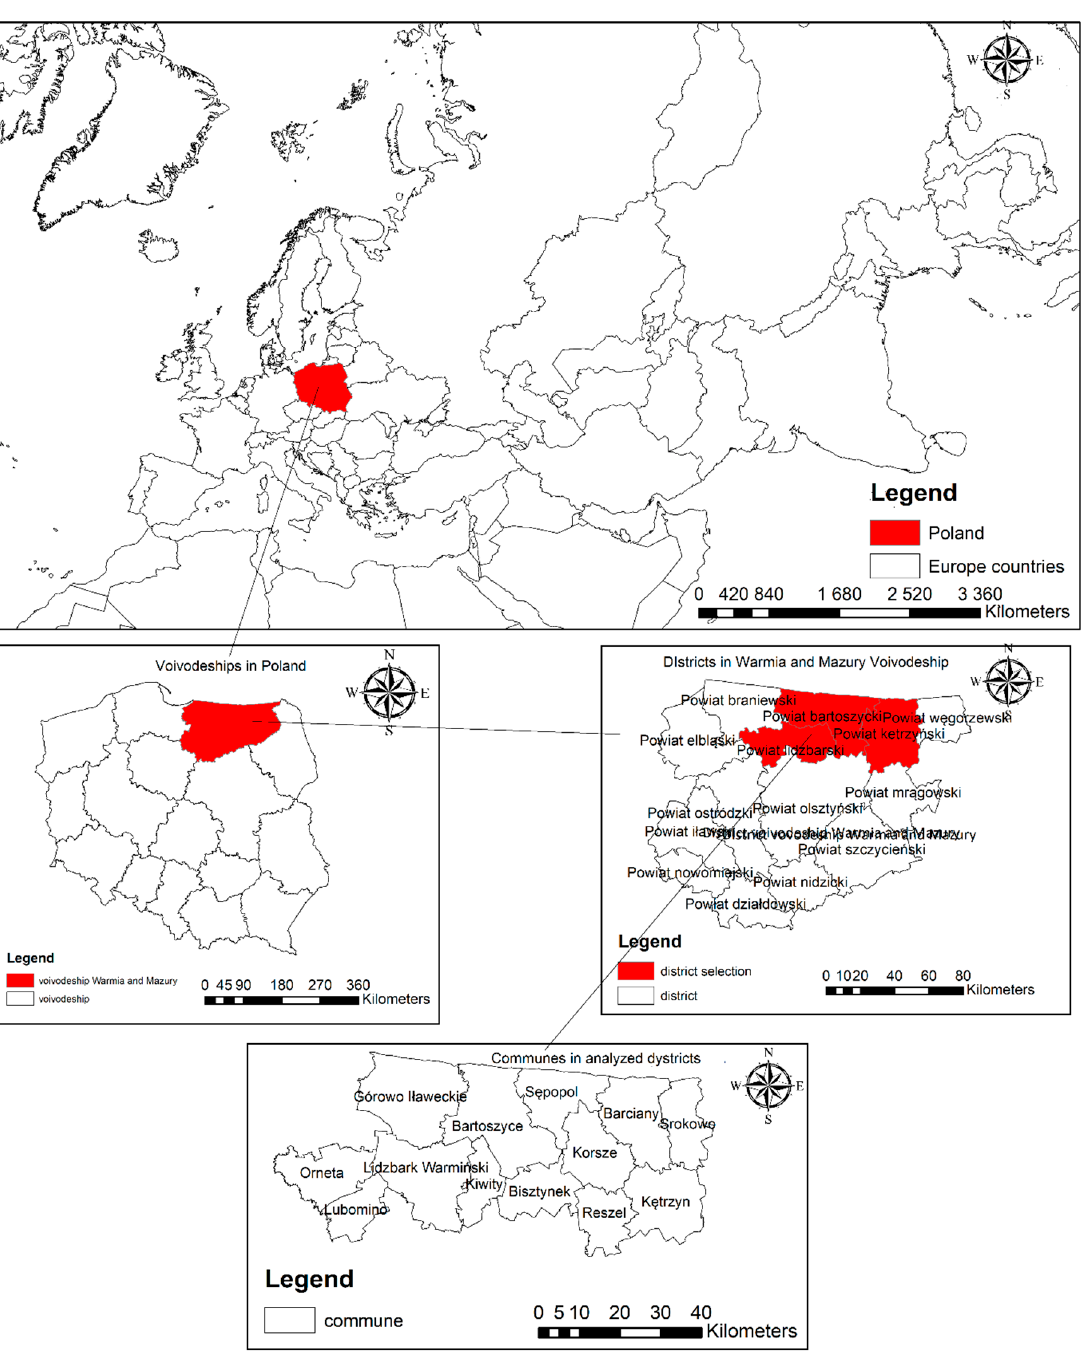
Figure 1. The research area.